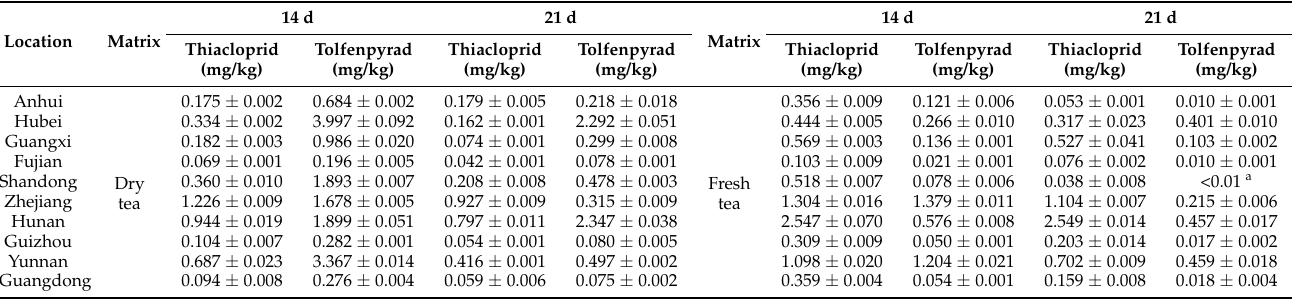
Table 4. Terminal residues of thiacloprid and tolfenpyrad in different tea matrices at different preharvest intervals